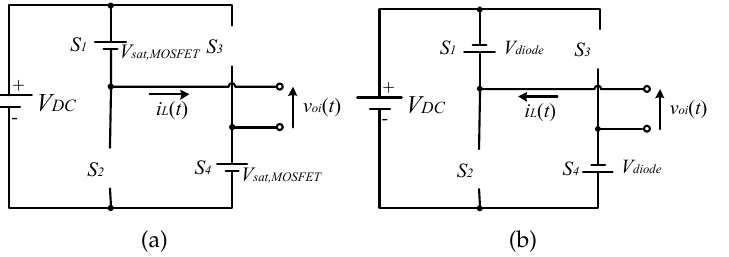
Figure 13. Equivalent circuit of an H-bridge for voltage sag analysis; ( a ) for positive load both voltage and current, ( b ) for positive load voltage and negative current.